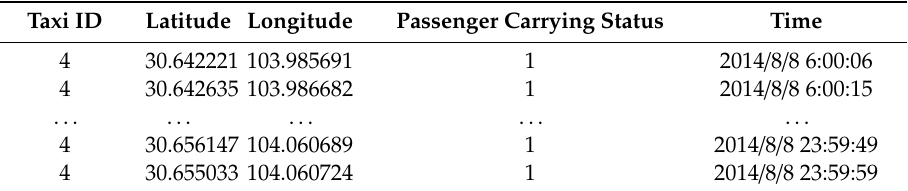
Table 1. The taxi trajectory of Taxi ID